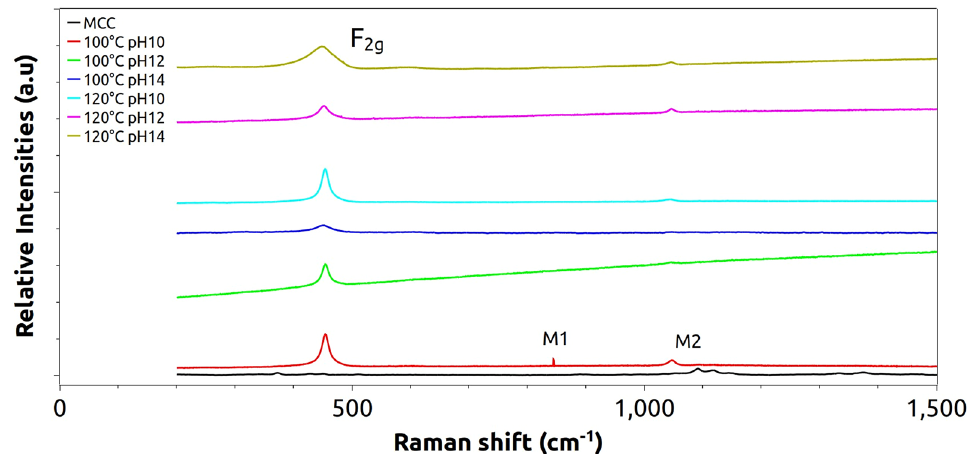
Figure 6. Raman spectra of the hybrid structures and the